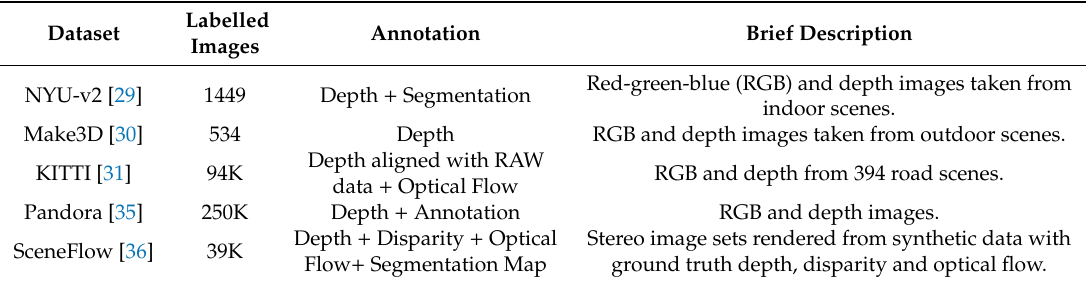
Table 1. Datasets for monocular depth